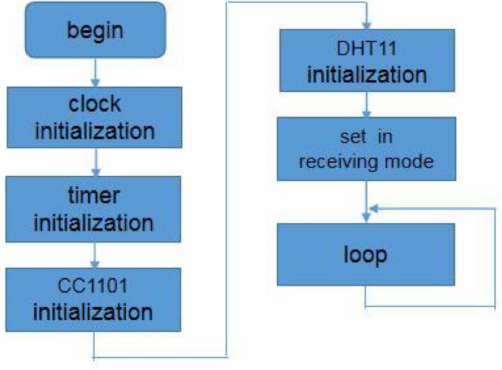
Figure 9. The flowchart of sensor